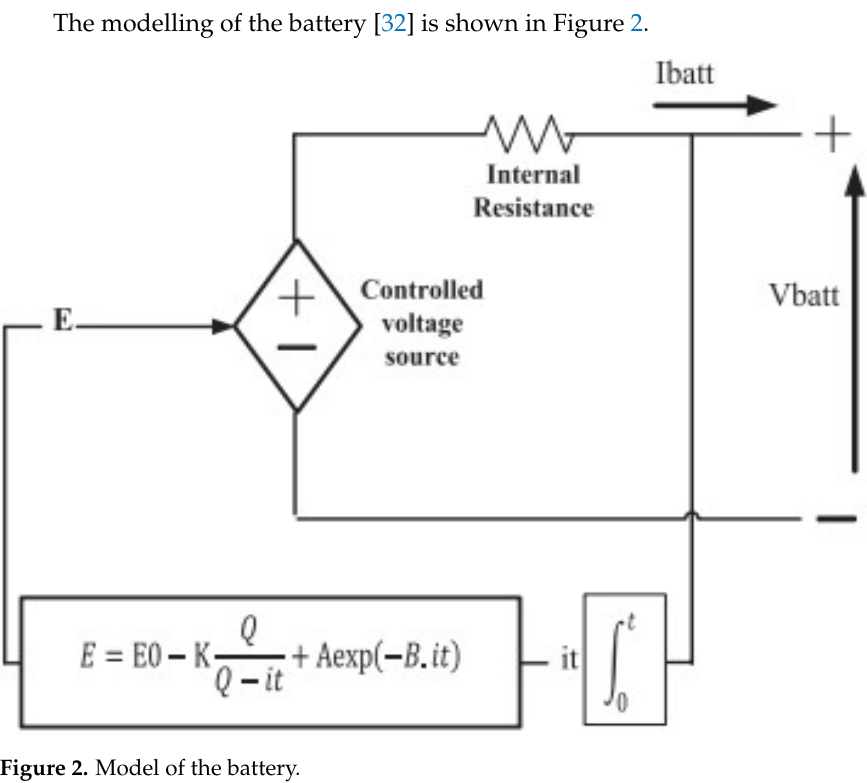
Figure 2. Model of the battery.